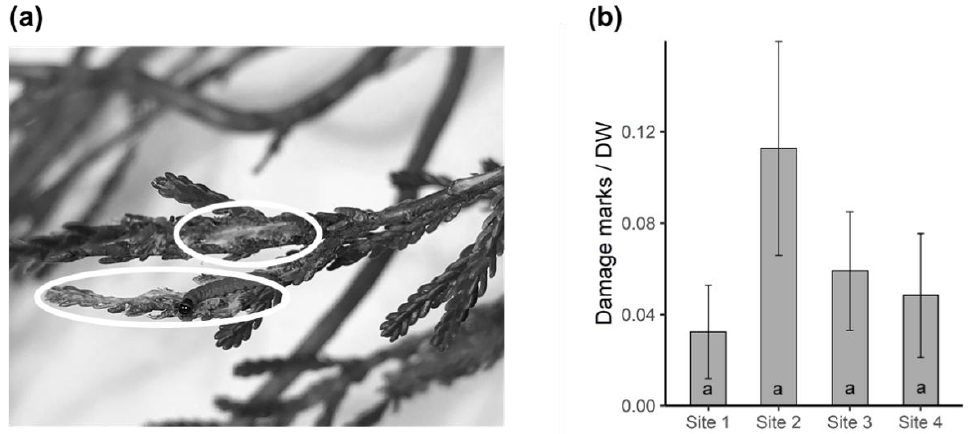
Figure 6. ( a ) Visible herbivore damage on heather. Sections in white circles were counted as two separate damage events. ( b ) Mean number of damage marks counted on target plants (n = 5) for each site expressed as damage per gram dry weight.